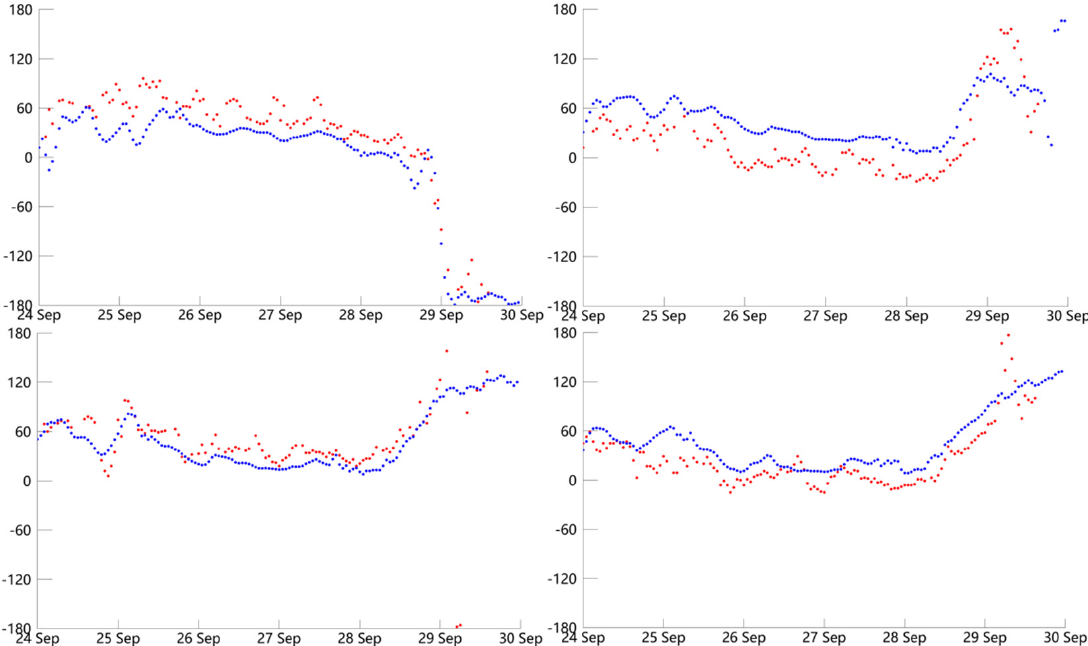
dot) and buoy observations (red dot) during typhoon Goni at the locations of four buoys.